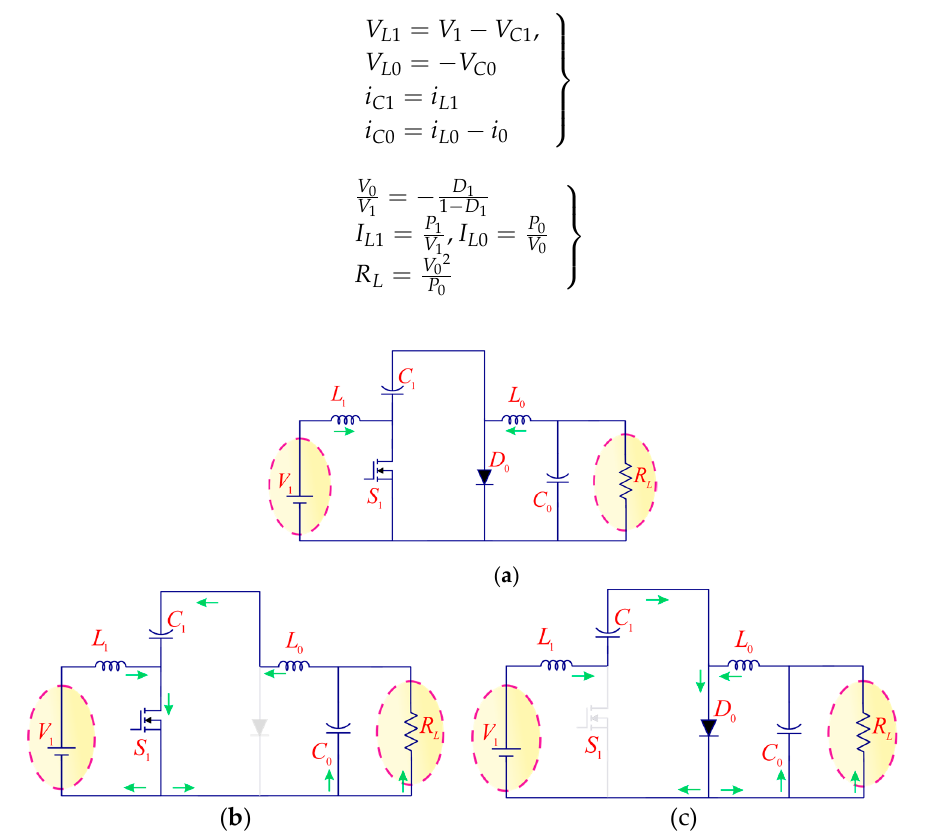
Figure 5. ( a ) Single input–single output (SISO) mode of the proposed converter: ( b ) State 1 and ( c ) State 2.